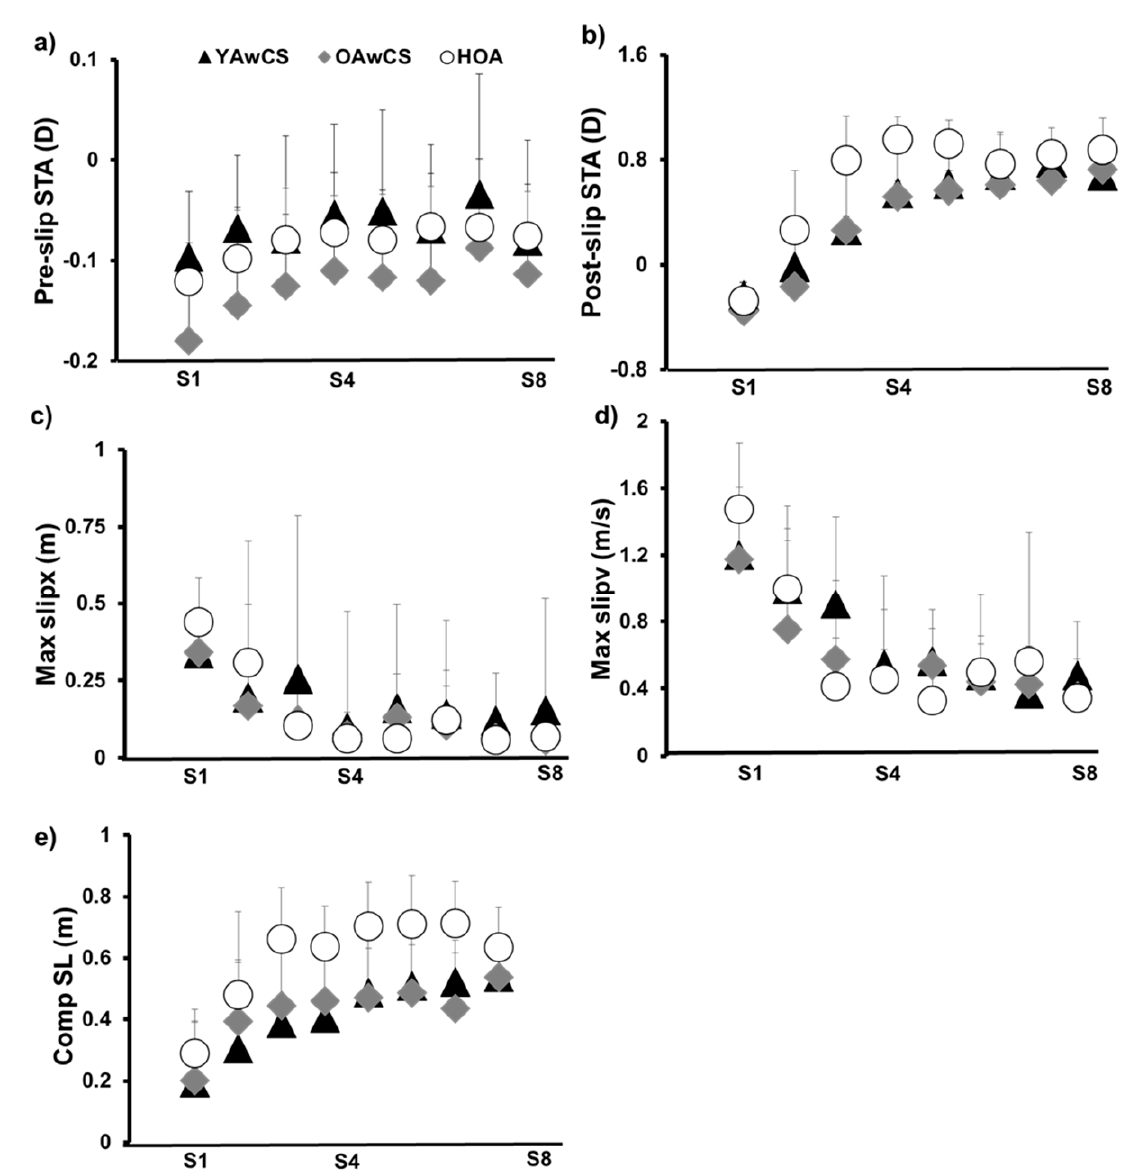
Figure 3. ( a ) Pre-slipping center of mass (COM) stability (Pre-Slip STA) (D − Dimensionless) com- puted at the instance of slipping limb touchdown; ( b ) Post-slipping center of mass (COM) stability (Post-Slip STA) (D − Dimensionless) computed at the instance of recovery limb touchdown; ( c ) Max- imum slip displacement (Max slipx) (m − meters) measured from the instance of slip onset to the instance of slipping limb lift-off; ( d ) Maximum slip velocity (Max slipv) (m/s − meters/second) meas- ured as the first derivate of maximum slip displacement from the instance of slip onset to the in- stance of slipping limb lift-off; ( e ) Compensatory step length (Comp SL) (m − meters) measured as the distance in anterior-posterior direction between the heel markers of the slipping and recovery limb at the instance of recovery limb touchdown; for young adults with chronic stroke (YAwCS), older adults with chronic stroke (OAwCS) and healthy older adults (HOA) during a block of eight consecutive slips delivered to the non − paretic (YAwCS and OAwCS)/dominant side (HOA) (S1 − S8). Table 2. Means and standard deviations of adaptation rate for all the kinematic variables. Kruskal– Wallis test was conducted to examine the group effect on the adaptation rate. Adaptation Rate